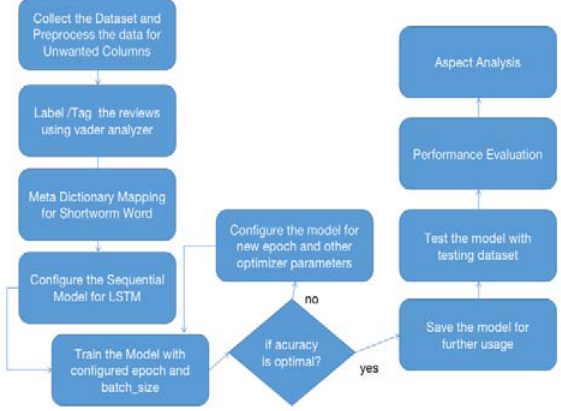
Fig. 3. Proposed system flow chart